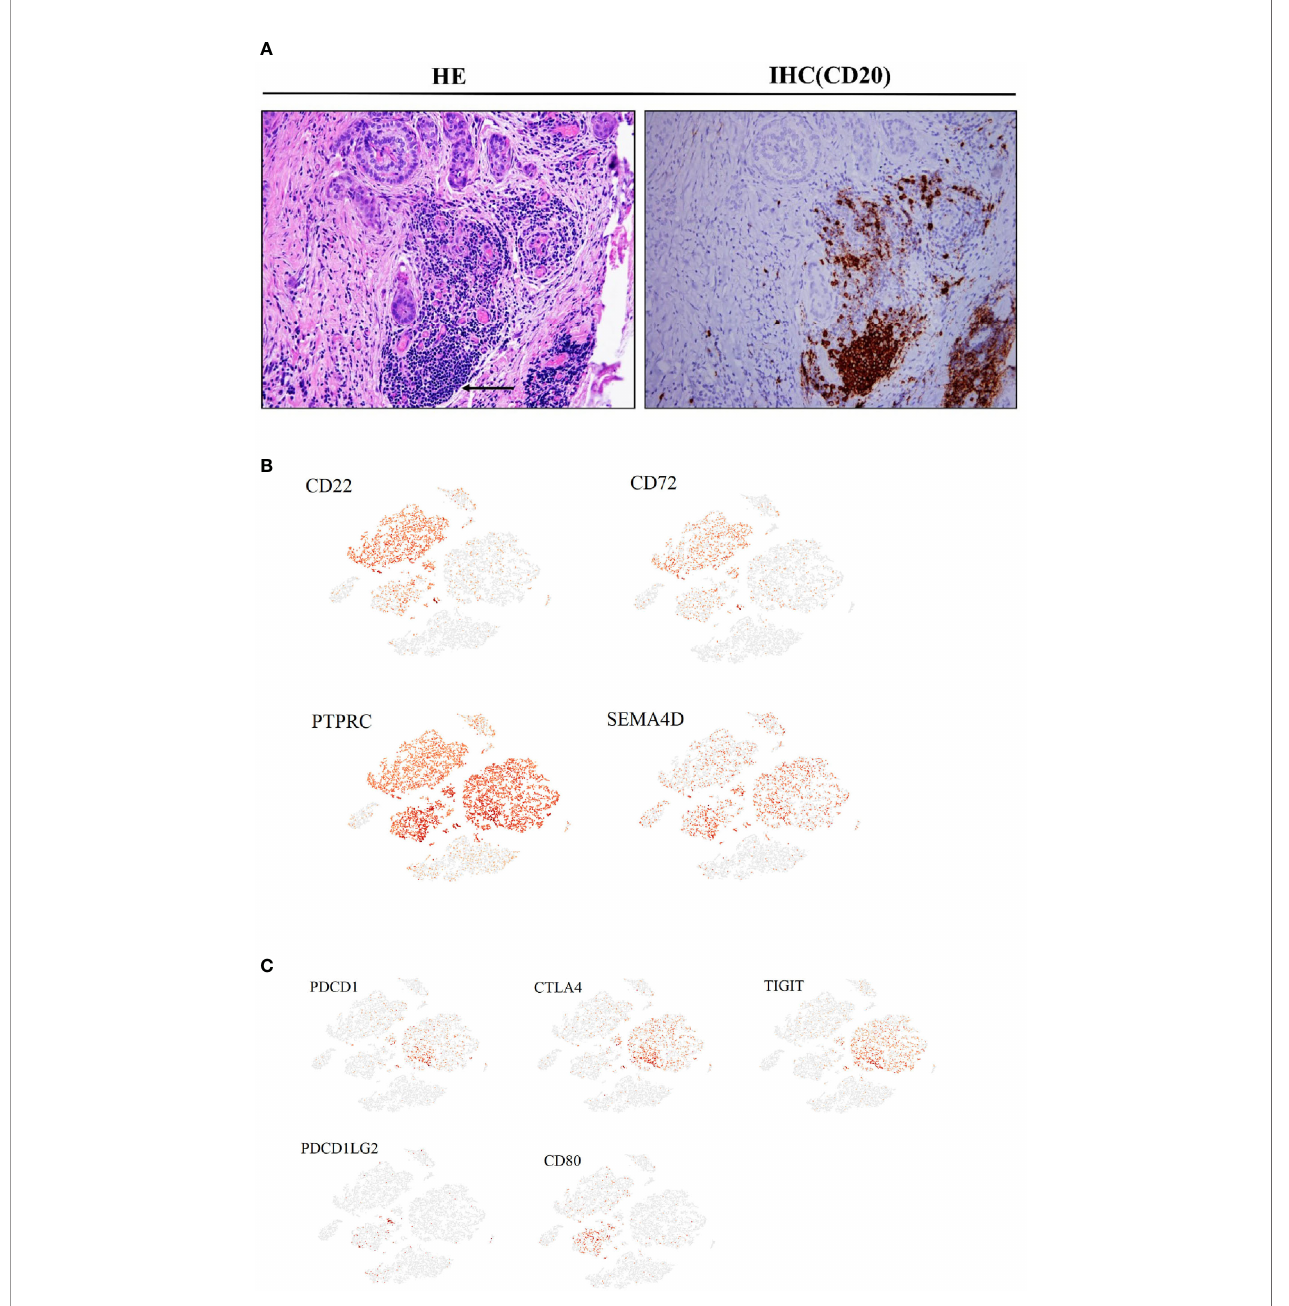
FIGURE 4 | Cancer-associated immune cells and inhibitory regulation in PTC (Ca, primary PTC; LN, lymph node metastasis; PCa, paracancerous tissue). (A) IHC with CD20 antibodies in another PTC cohort(original magni fi cation 20×). (B) Expression levels of CD22, CD72, PTPRC and SEMA4D on the t-SNE plot, with each cell colored based on the relative normalized expression. (C) Expression levels of PDCD1, CTLA4, TIGIT, PDCD1LG2 and CD80 on the t-SNE plot with each cell colored based on the relative normalized